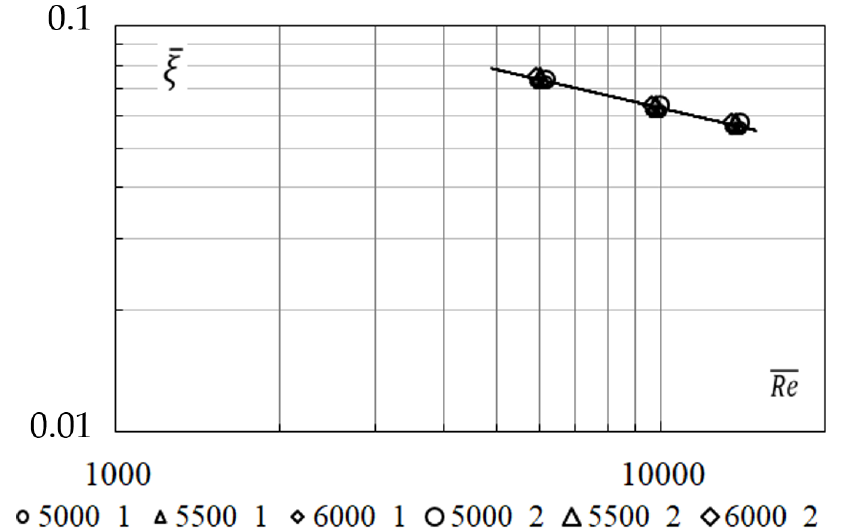
Figure 18. Generalized dependence of average coefficient of resistance of friction 𝜉̅ on the dimension- less coordinate Re